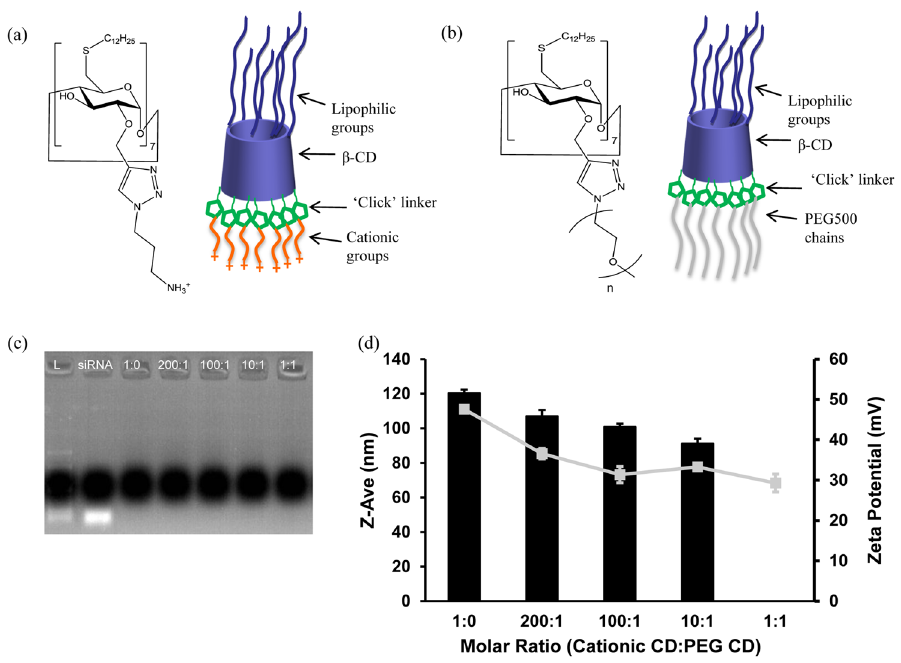
Figure 1. Chemical structures and properties of CDs and complexes. (a, b) Chemical structures and schematic representations of Cationic CD (a) and PEGylated CD (n=10–12) (b). (c) Gel electrophoresis showing siRNA binding within co-formulated CD.siRNA complexes. (d) Size (Z-Ave (nm), black bars) and charge (zeta potential (mV), grey square boxes) of co-formulated CD.siRNA complexes. Data are presented as the Mean 6 S.D (n=3).